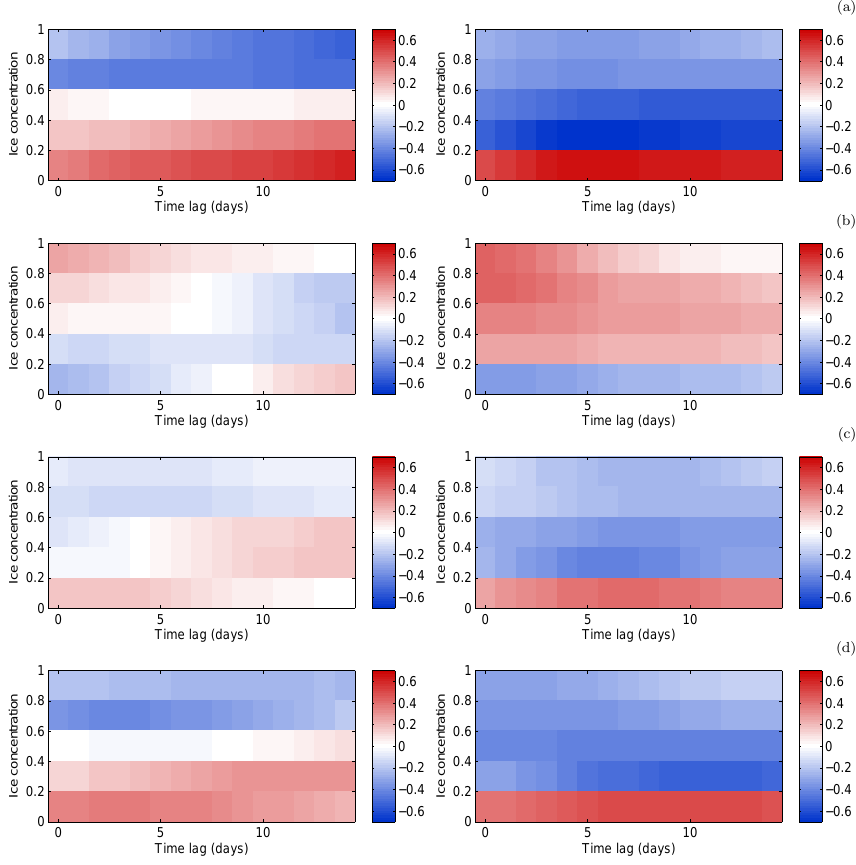
Fig. 7. Correlation between S 0 – 20 , ..., S 80 – 100 (area covered with ice concentration from a given range, marked on the vertical axis) and i i the meteorological parameters in the Bothnian Bay (left) and the Baltic Proper (right) for time lags up to 14days. The parameters are: the air temperature T a (a) , the daily air temperature range 1T a (b) and the W-E (c) and S-N (d) components of the wind velocity, respectively. Results are for all three winters in the simulation period. Correlations higher than 0.2 are significant at the 95% confidence